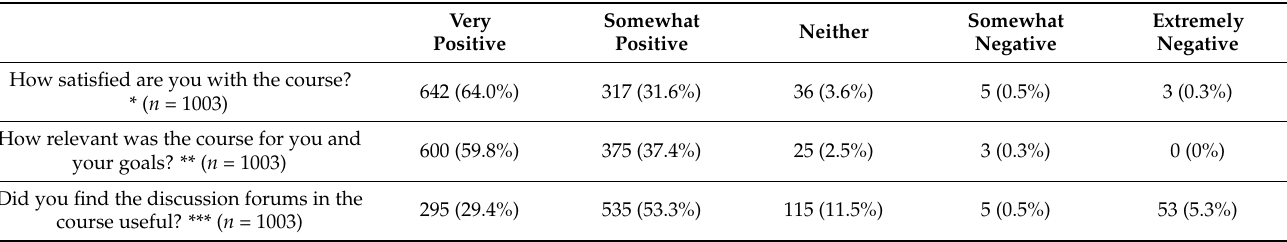
Table 5. Participant reaction to the